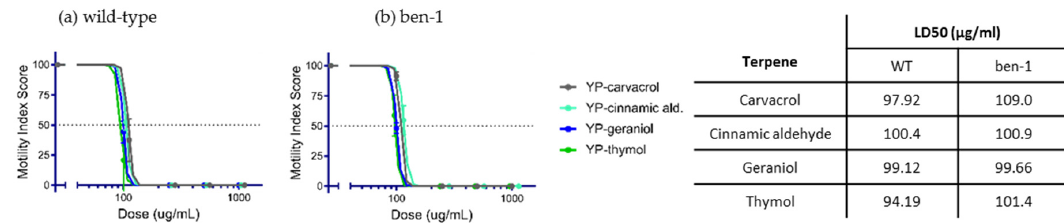
Figure 5. Dose–response curves and LD50 values of fast-acting YP-terpenes on ( a ) wild-type (WT) and ( b ) albendazole ben-1(e1880 )-resistant C. elegans . N = 20 L4–adult worms per condition scored at 6 days.